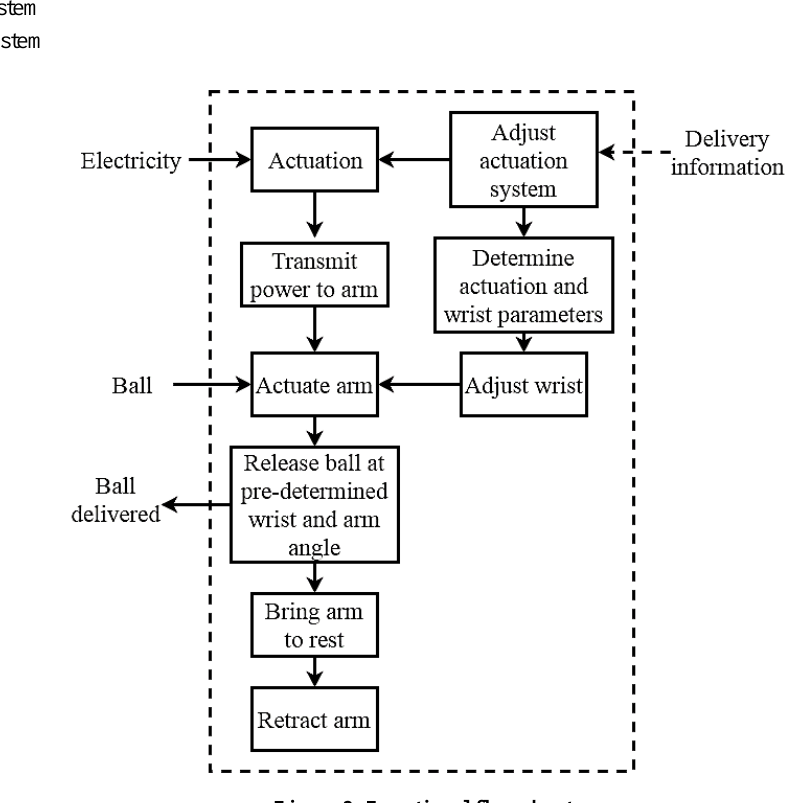
Figure 3. Functional flow chart